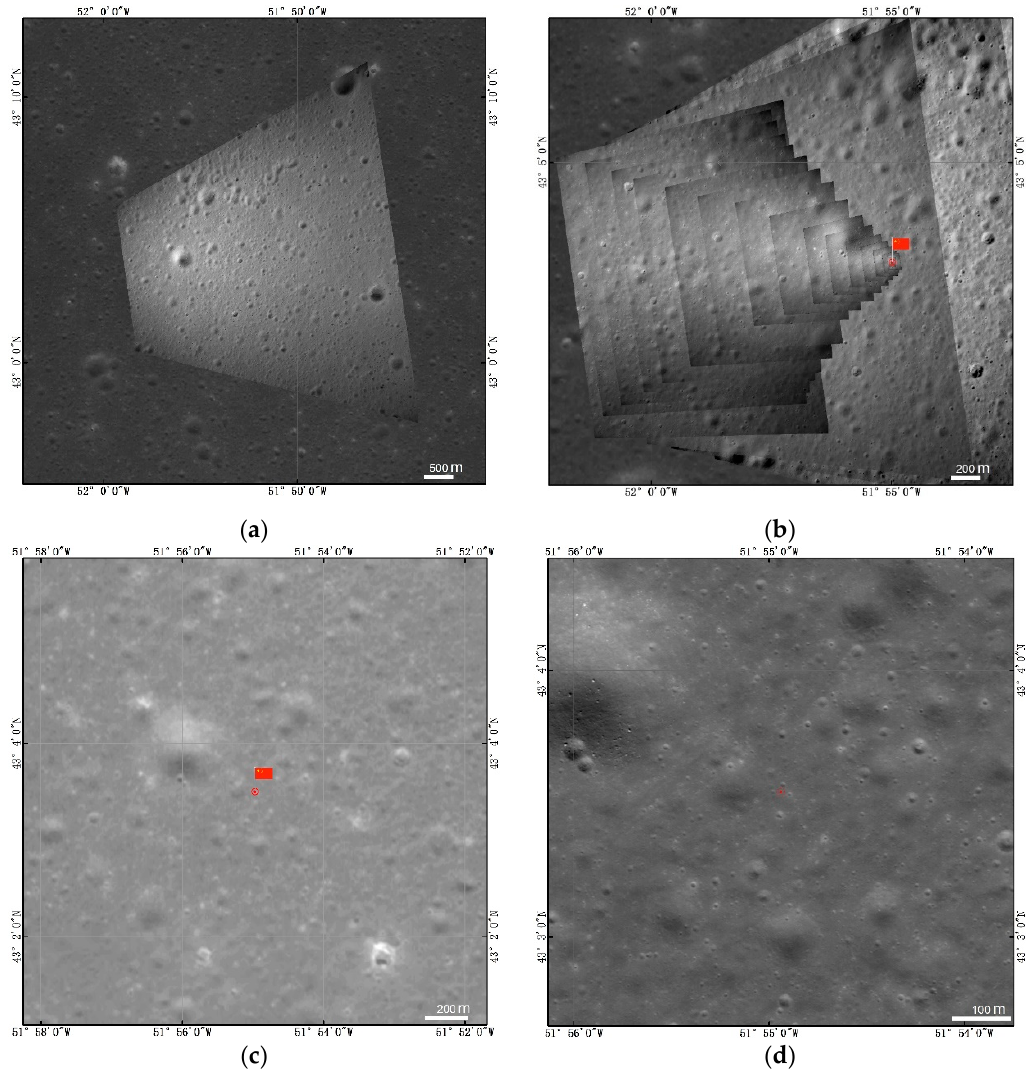
Figure 3. Image-based localization of the lander ( a ) image matching and rectification, ( b ) sequential image matching and rectification, ( c ) lander localization in the Chang’e-2 base map and ( d ) lander localization in Lunar Reconnaissance Orbiter Camera (LROC) Narrow Angle Camera (NAC) base map.